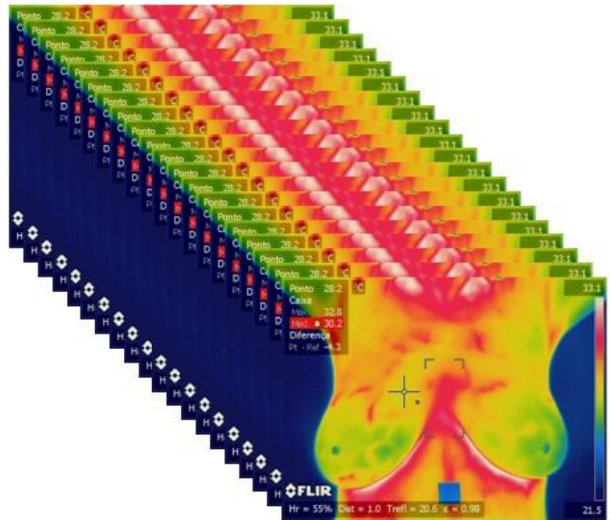
Figure 1. Capture of 20 sequential thermographies of a patient with a sick breast for 5 min by the used Dynamic Infrared Thermography (DIT)